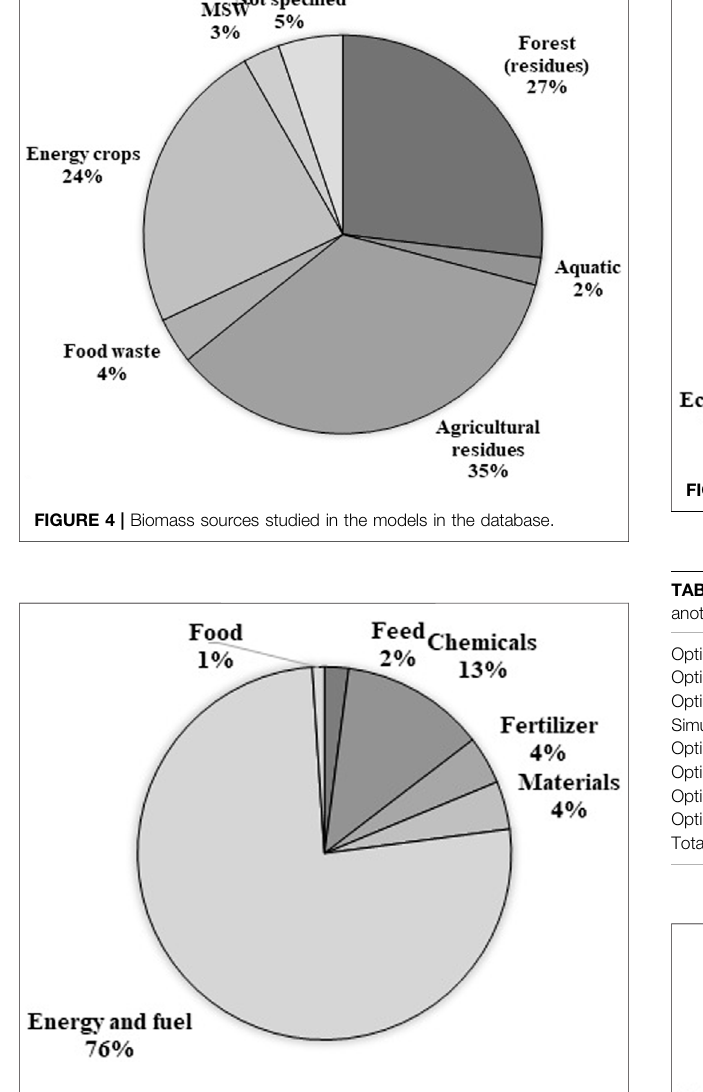
FIGURE 5 | Product (application area) of the models in the database.